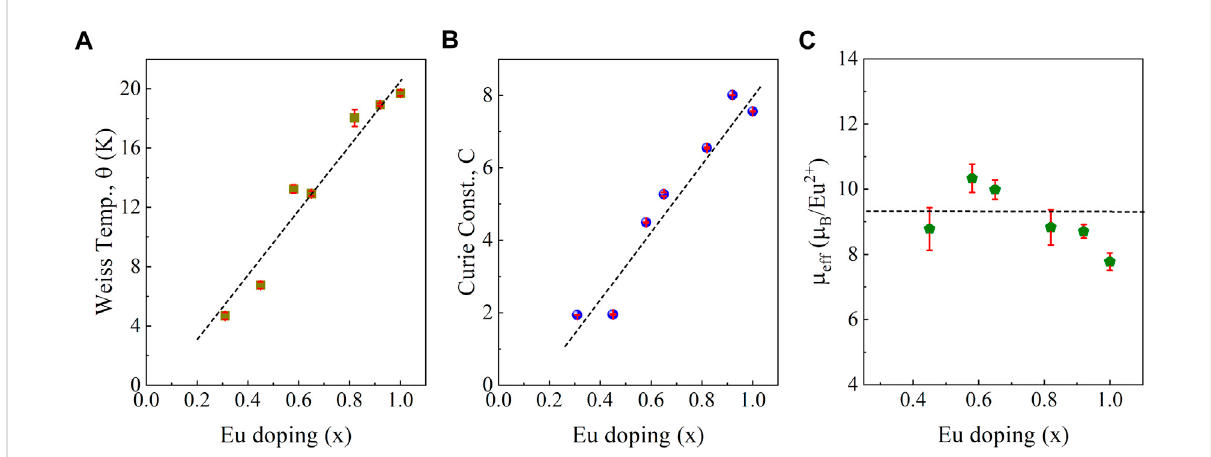
FIGURE 4 Weisstemperature,Curie-constant,andeffectivemoment.Thebest- fi tparameters (A) θ (K)and (B) C plottedasfunctionsofEudoping( x ).Both θ and C varynearlylinearlywithEudoping,asshownbythedashedlines. (C) μ increasing x , μ eff per Eu 2+ ion does not show a clear dependence on x , and its value varies between ~ 8 – 10 μ B